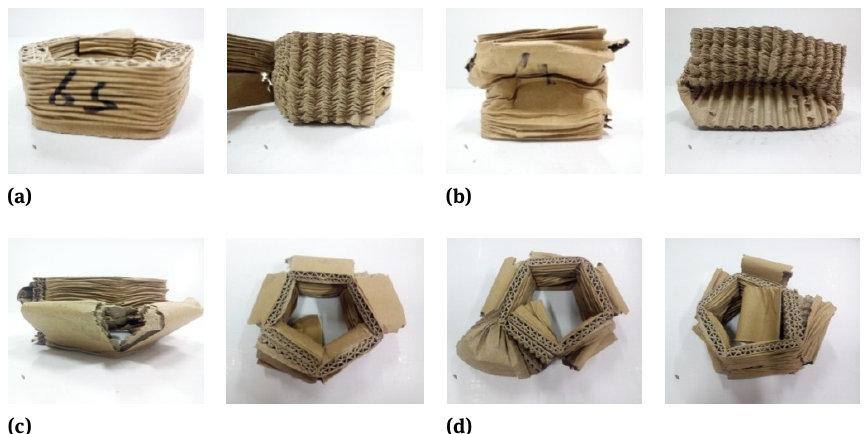
Figure 6: Deformation modes of regular pentagon paper corrugation tube along Y direction: (a) steady state progressive buckling; (b) Euler buckling; (c) angular tear; (d) transverse